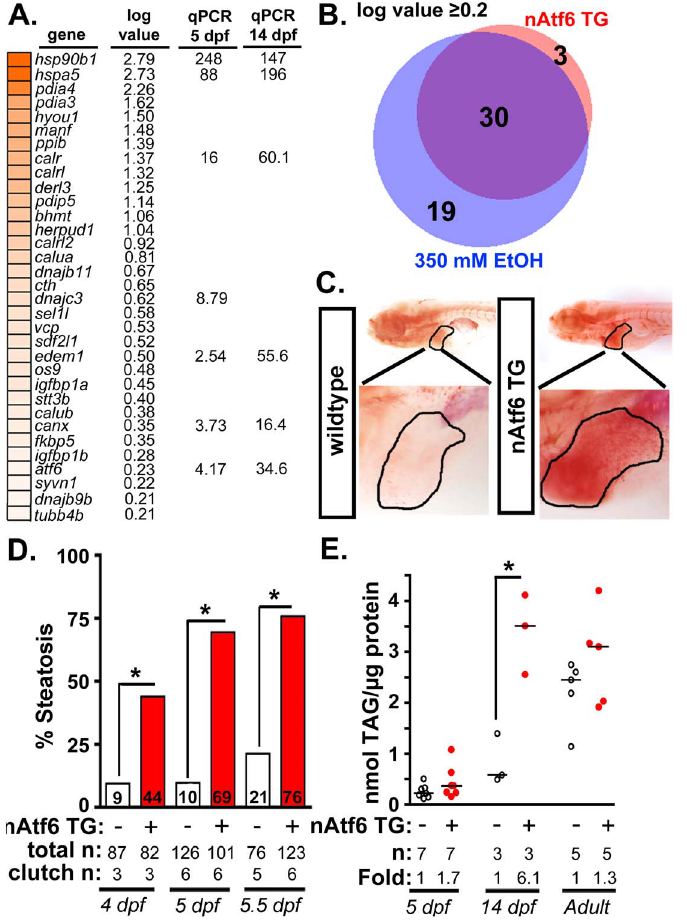
Figure 2. nAtf6 overexpression is sufficient to drive steatosis. A: Heatmap of upregulated UPR effector genes in nAtf6 transgenic larvae. The log values based on mRNA-Seq analysis and the median fold change in 3–6 liver samples assessed by qPCR at 5 dpf and 14 dpf. B: Most Atf6 targets are upregulated in the liver in response to ethanol. Genes identified as part of the UPR are significantly induced in the liver of nAtf6 TG and ethanol treated larvae (log value $ 0.2; see Table S2). C: Oil red O stained WT and nAtf6 transgenic larvae. Livers are circled in the enlarged boxes. D: Steatosis incidence based on scoring of whole mount oil red O stained larvae at 4, 5, and 5.5 dpf. Statistics: chi-square with Fisher’s Exact Test. *, p , 0.05. ‘‘Total n’’ and ‘‘clutch n’’ corresponds to the number of larvae and number of clutches scored. E: Hepatic triglyceride levels in extracts from pooled livers from WT and nAtf6 transgenic larvae at 5 dpf and 14 dpf, and from single adult livers ( , 9 months). Statistics: unpaired t-test. *, p , 0.05. Median fold changes are